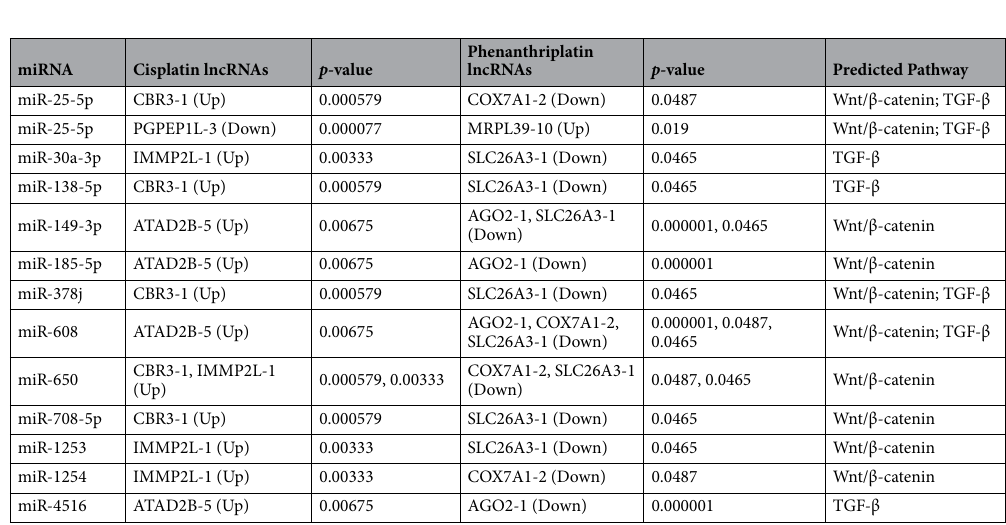
Figure 2. Validation of long non-coding RNA microarray expression data using qRT-PCR. ( a ) A549 cell line results for PTBP1-2 (PT), IMMP2L-1 (IM), RIPPLY3-5 (RI), TRIM55-1 (TR), and RARB-1 (RA). ( b ) IMR90 cell line results for MRPS5-1 (MR), HYPM-1 (HY), NLRP12-1 (NL), FAM237B-2 (FA), TMEM243-1 (TM), and TRIM55-1 (TR). Key: “-M” = microarray (light gray); “-P” = qRT-PCR (dark gray). Error bars represent mean ± standard deviation, N = 3.